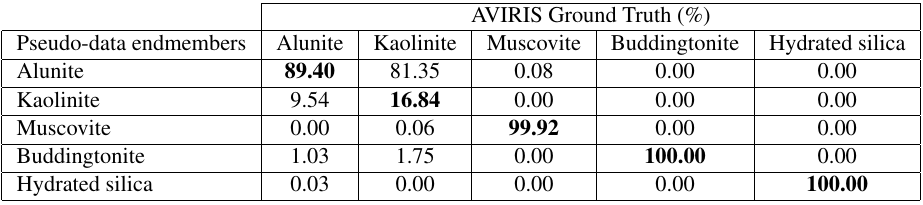
Table 3: Confusion matrix comparing the mineral mapping results between pseudo-hyperspectral and AVIRIS images kaolinite, alunite, muscovite, hydrated silica (chalcedony and/or opal), and buddingtonite, were determined based on the result of purest pixels in n-dimensional space (n-D Visualizer). Spectral Angle Mapper (SAM) method was used to produce distribution and abundance maps of selected